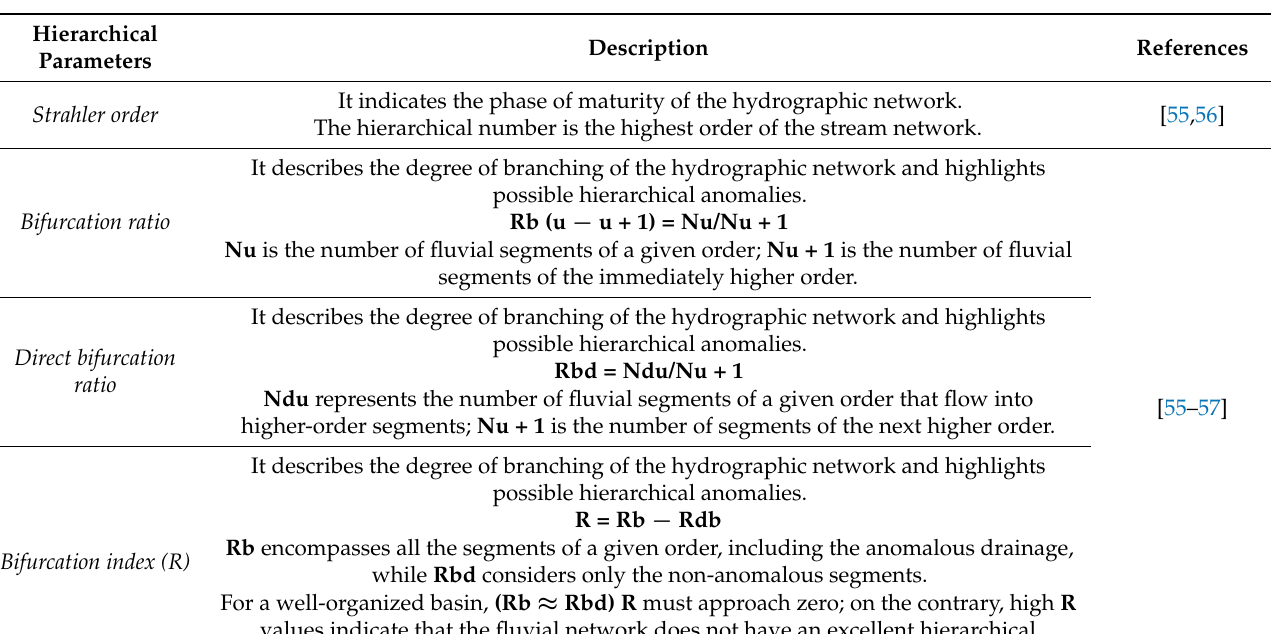
Table 1. Hierarchical parameters and geomorphic